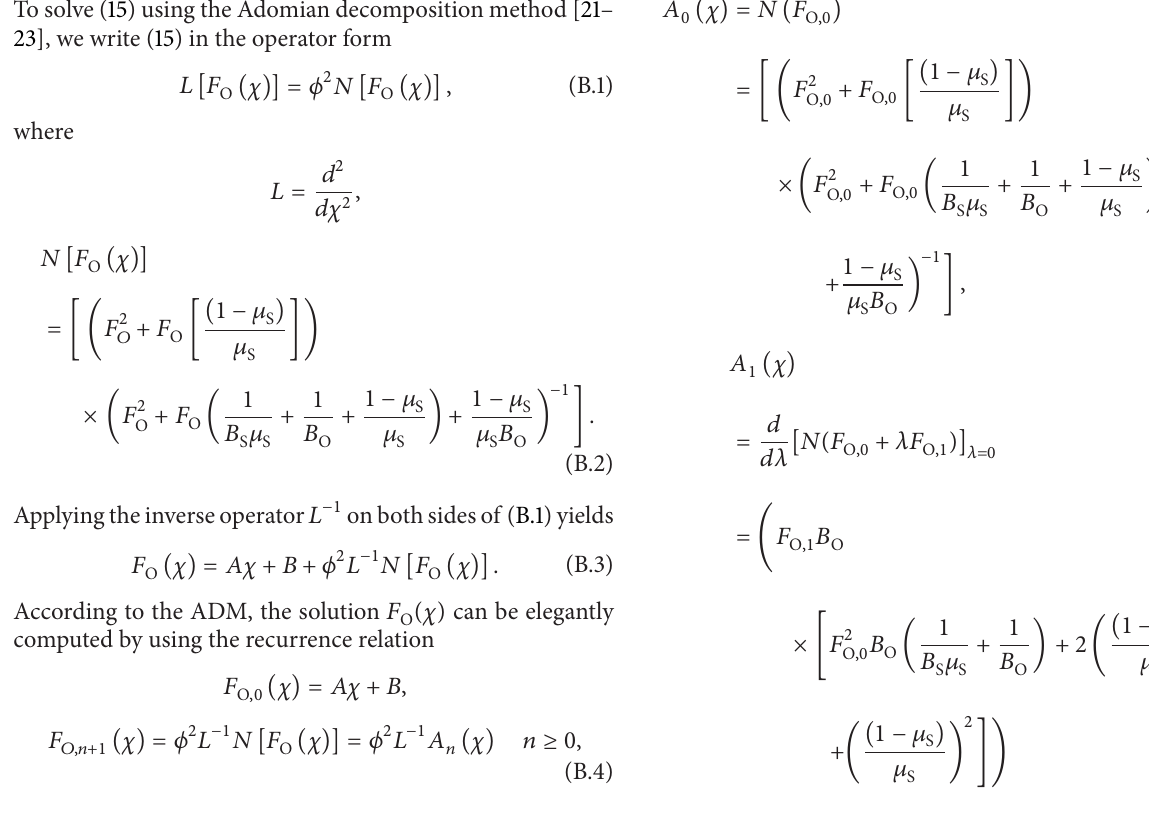
Figure 5: Variation of normalized current 𝐼 with (a) normalized surface concentration of oxidized mediator 𝐵 concentration of the substrate 𝐵 = 200 ( 𝑑 = 111.42 𝜇 M) (iv) 𝜙 2 (iii) 𝜙 2 O